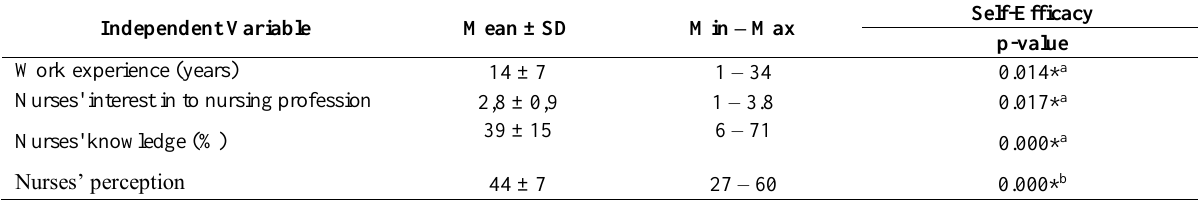
Table 3. Bivariate Analysis of Dependent and Independent Variables of ICU Nurses (n = 127) Independent